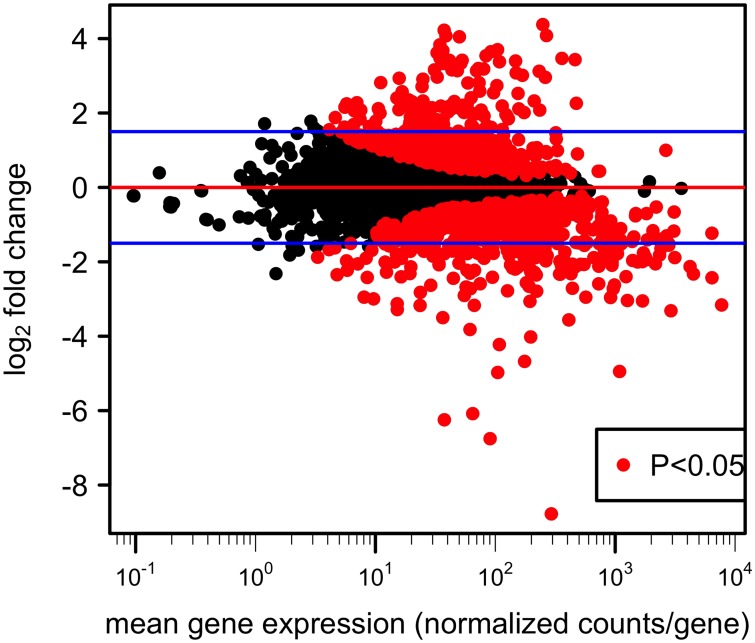
Differential gene expression plot.The fold change in the expression of each gene is plotted against mean gene expression. Red points represent genes with significant differential expression in IDH781 and EA1002 (P < 0.05). The blue bars indicate log2 fold change at 1.5.